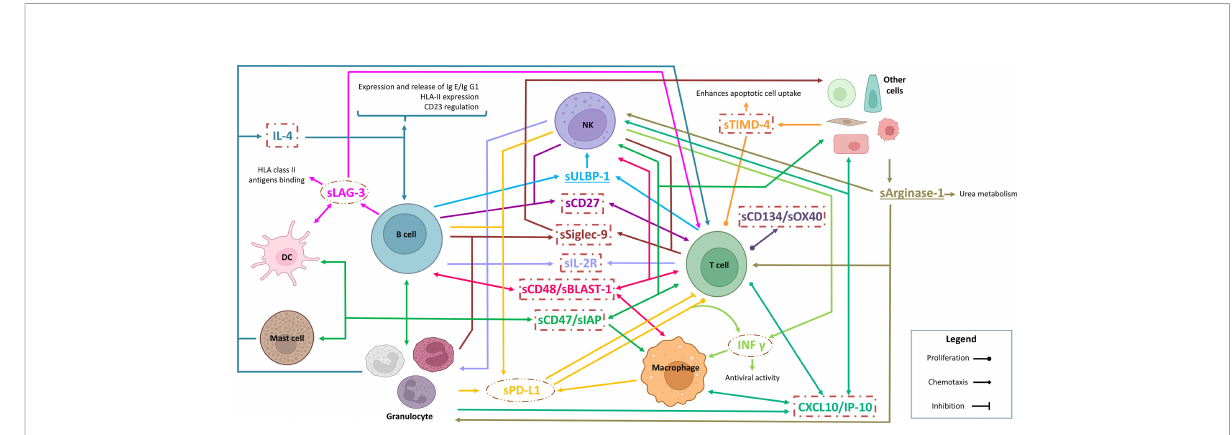
FIGURE 8 Model of the role of soluble immune checkpoints in the TME in the studied cohort. Inside circles, protein pro fi ling decreased levels according to disease evolution. Inside squares, protein pro fi le correlated with mutated IGHV. Underline, protein pro fi les with fl uctuations over disease evolution and IGHV mutational status. (Created in